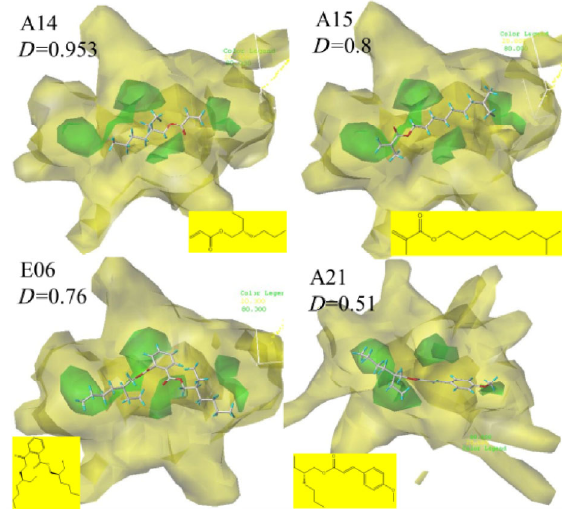
Fig. 2 CoMFA contour diagram for antiwear with embedded A14, A15 ， E06 and A21as reference for steric fields, respectively. Green and yellow regions represent the favored and disfavored steric bulk, respectively.